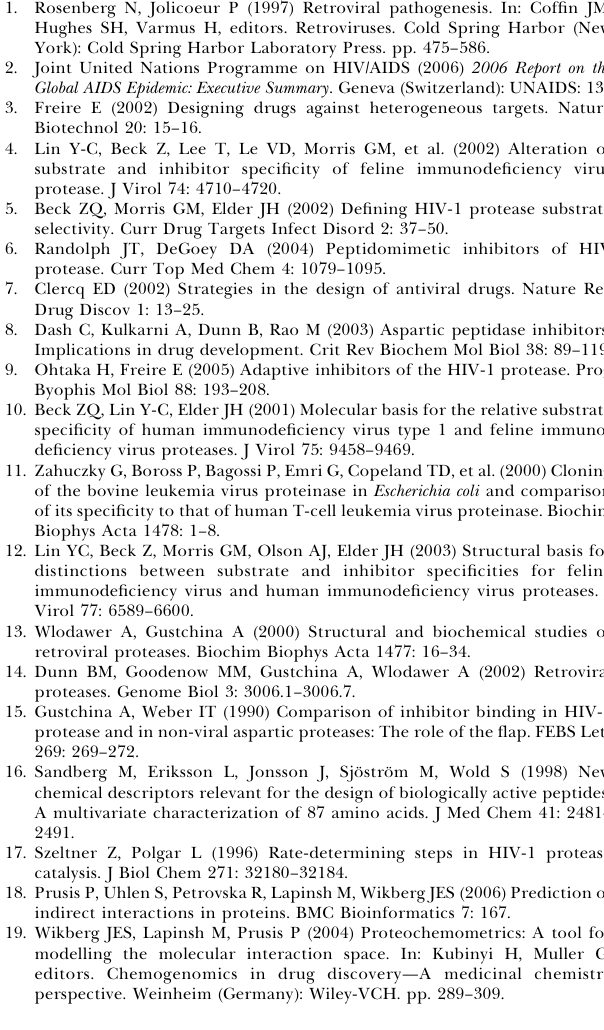
Table S3. Descriptors of Assay Conditions Used for Determination of Substrate Cleavage Rates Found at doi:10.1371/journal.pcbi.0030048.st003 (40 KB DOC).